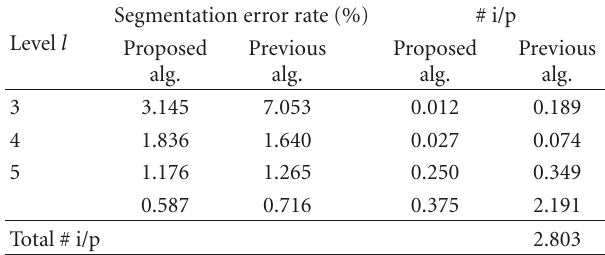
Table 3: Comparisons of performance in terms of segmentation error rates and computational cost measured by number of iteration per pixels (# i/p) for Image I of Figure